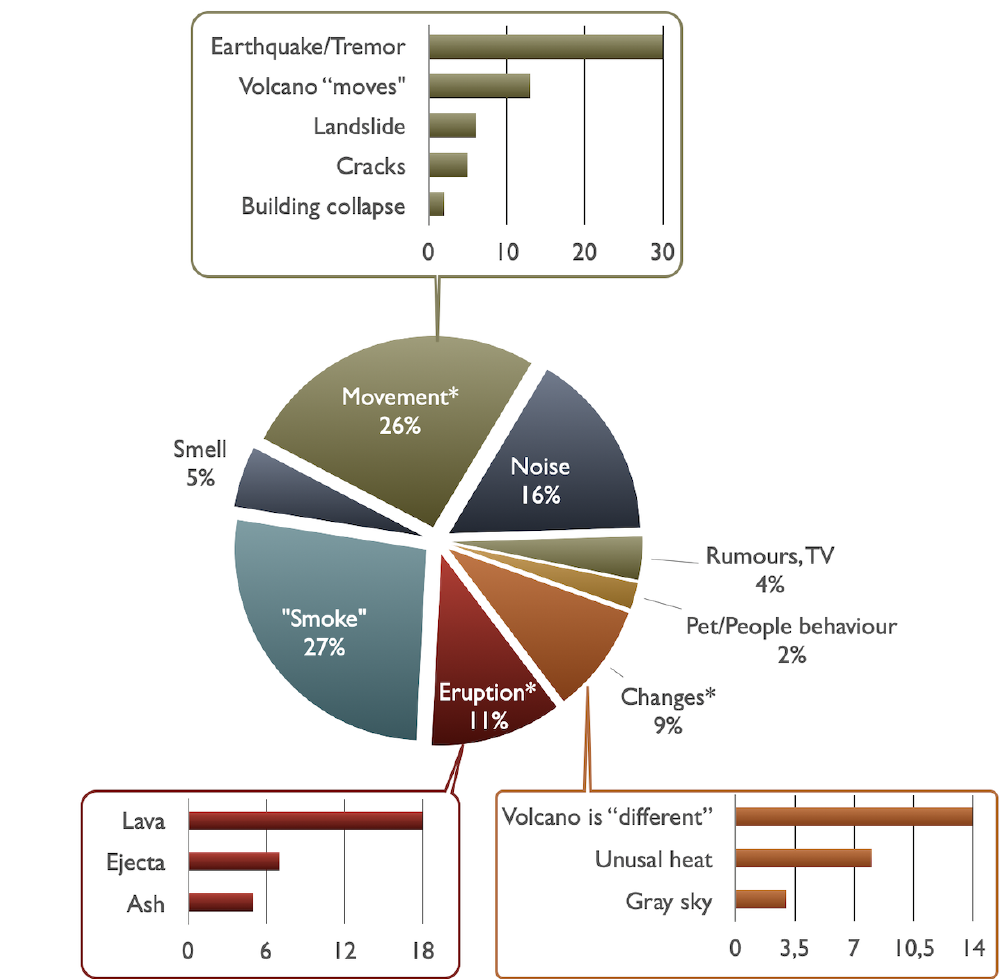
Figure 5. Signals of unrest mentioned in the collected stories (frame